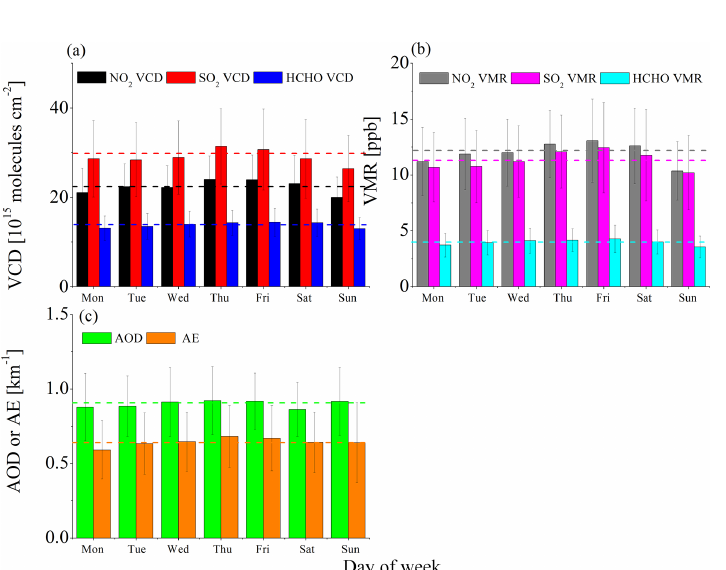
Figure 15. Mean weekly cycles of VCDs (a) and near-surface VMRs (b) of NO 2 , SO 2 and HCHO as well as the AODs and near-surface AE (c) for all MAX-DOAS observations from 2011 to 2014. The dashed lines denote the mean values during the working days from Monday to Friday (same colours as for the